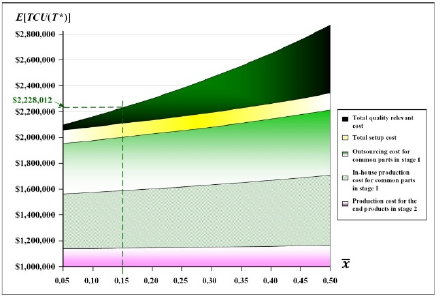
Fig. 10. Comparing E [ TCU ( T *)] of this research with different models